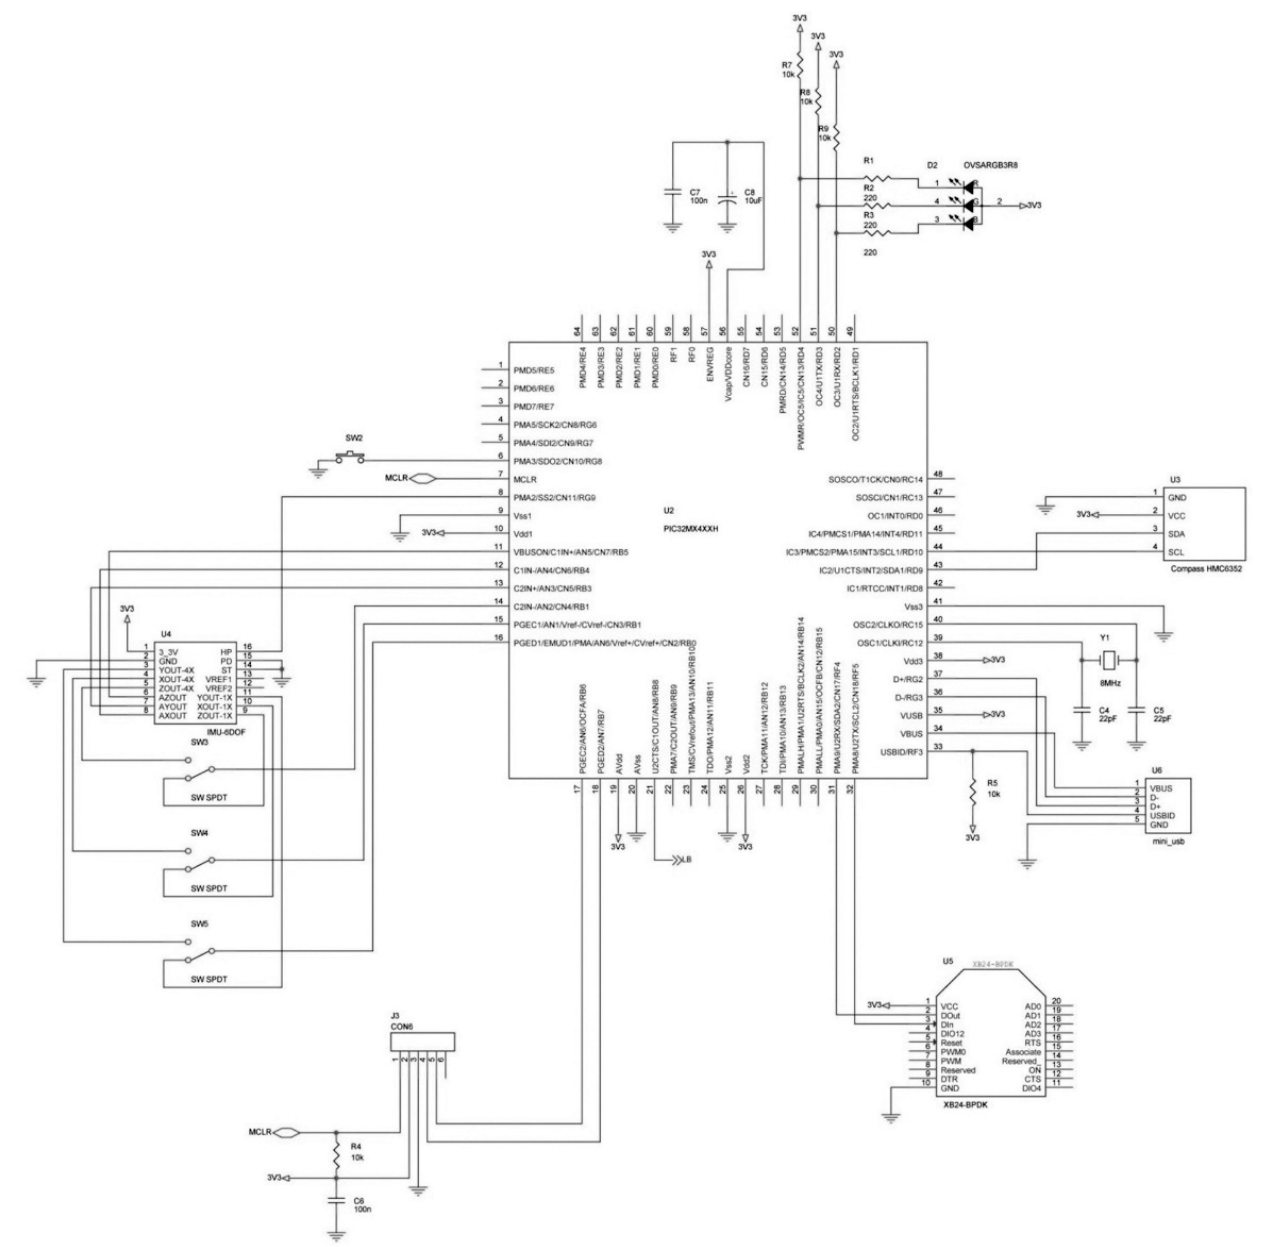
Figure B3. Schematic of the microcontroller and the ZigBee